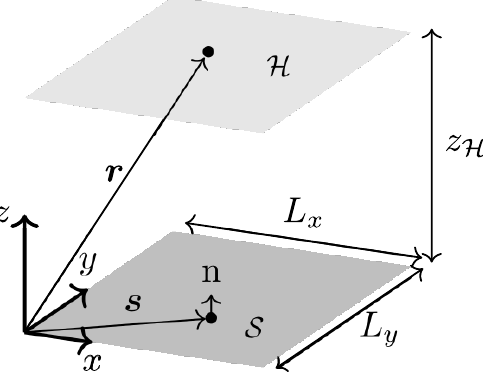
is a finite plane, vectors r , s and n are S . The radiated S at elevation z H H